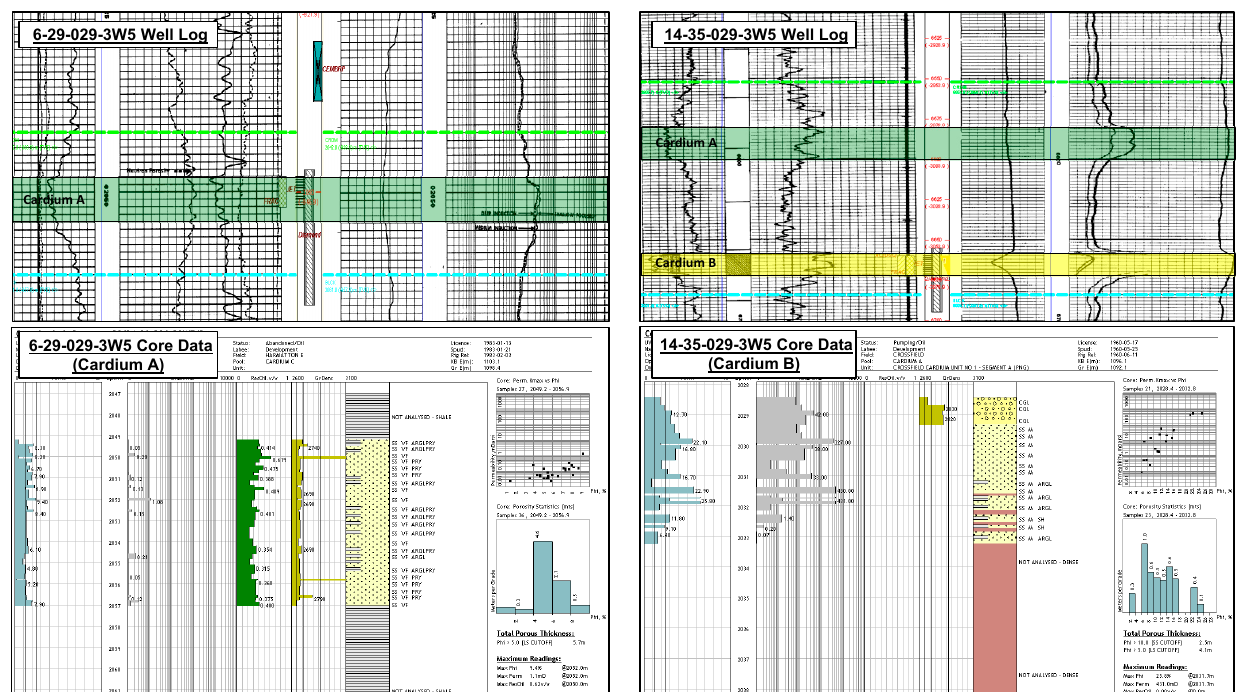
Figure 4. Well log and core analysis of the Cardium A and Cardium B